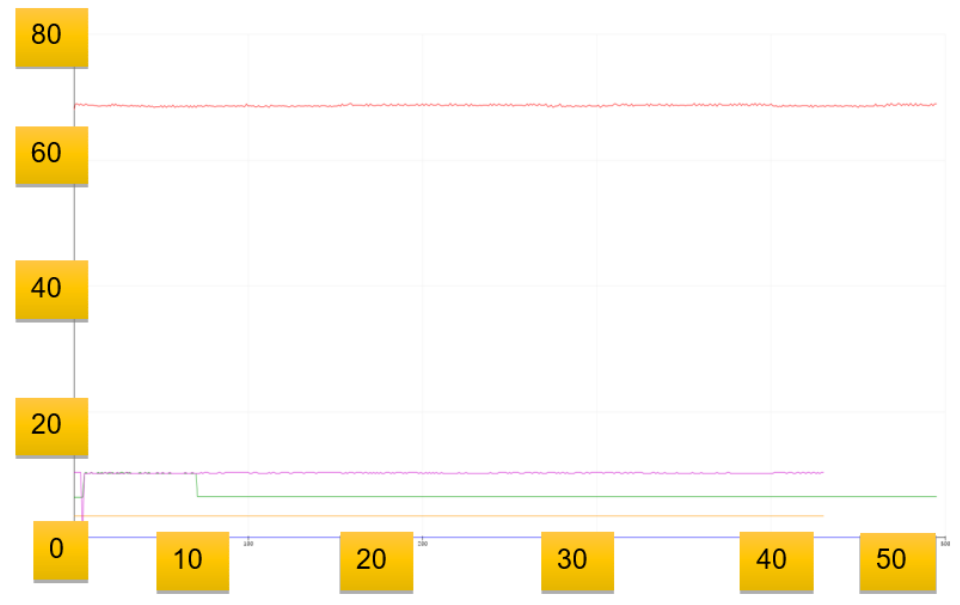
Figure 17. Humidity, Smoke, Temperature, Flame sensor in the absence of flame.